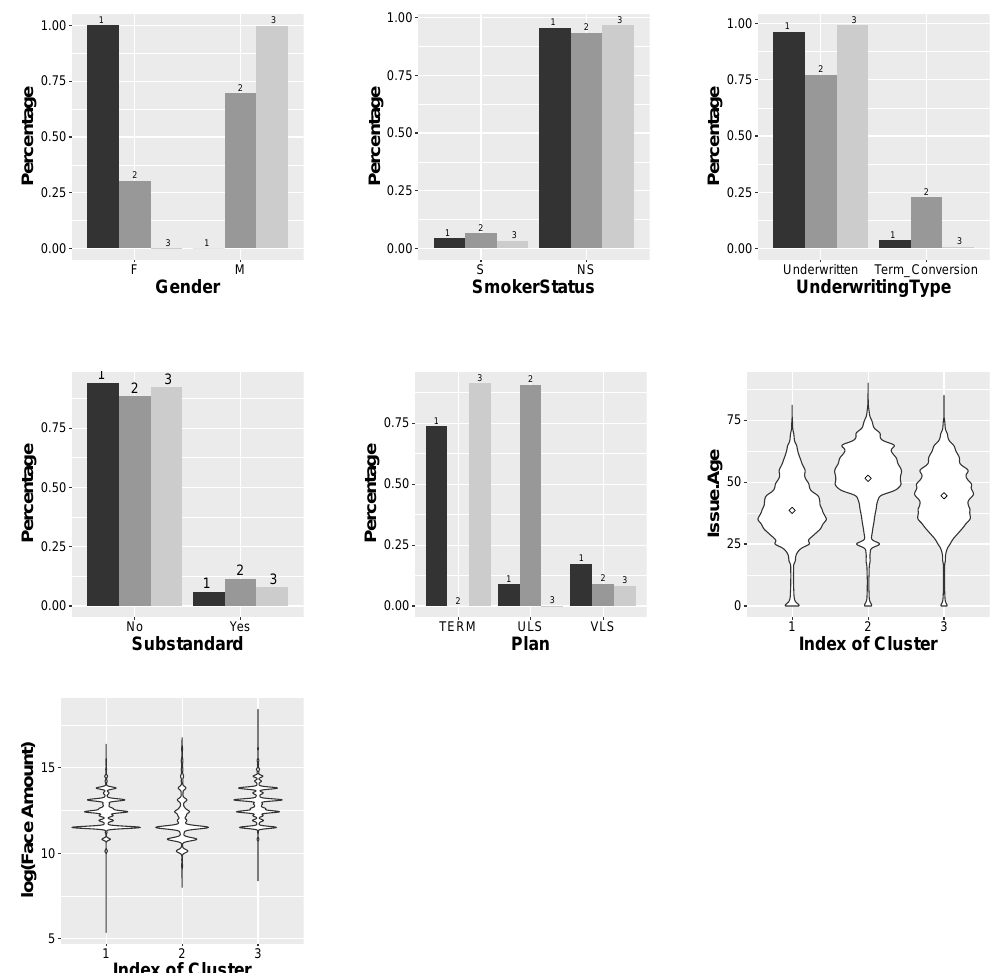
Figure 5. Distributions of the numerical and categorical attributes in each of the optimal